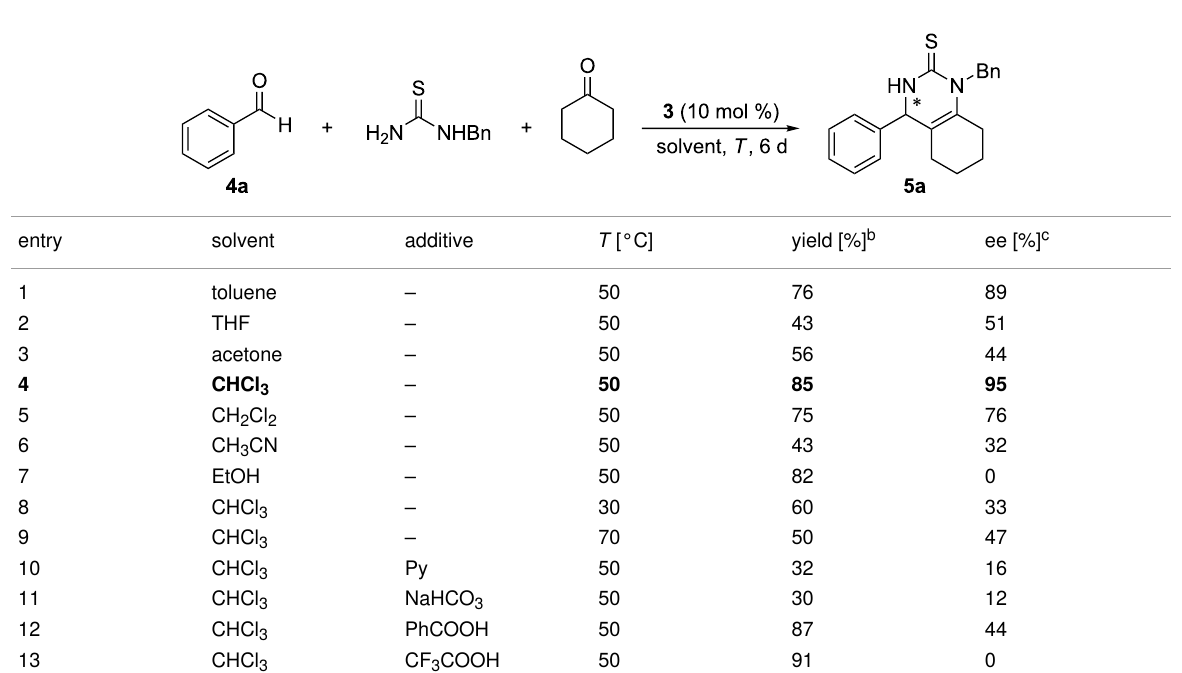
Table 2: Results of the Biginelli-like reaction with various aromatic aldehydes catalyzed by 3a a .